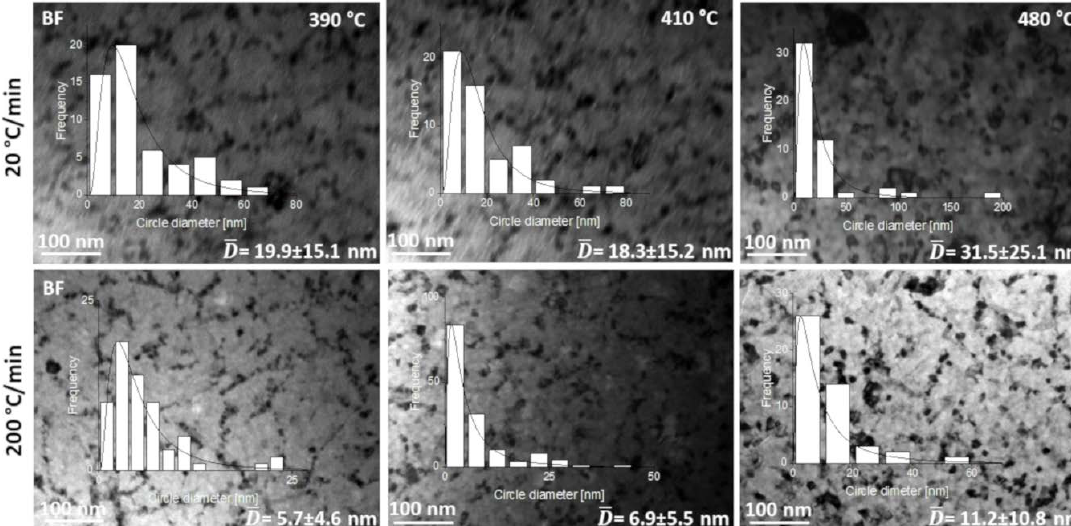
Figure 6. Set of BF microstructures recorded at different temperatures during in situ heating at 20 and 200 °C/min and the corresponding histograms of crystallite size distribution.